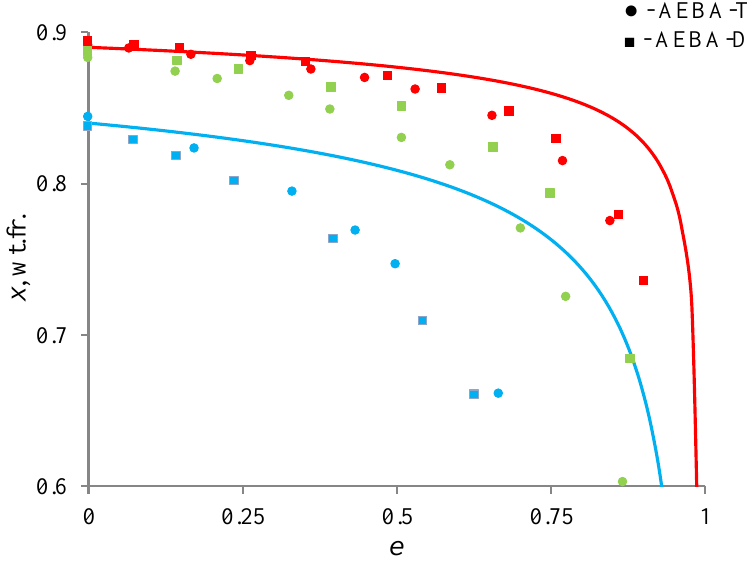
Figure 8. Change in the concentration of ethanol in a liquid mixture during open evaporation: red color is 0.1 wt.fr. of AEBA; green—0.2 wt.fr.; blue—0.6 wt.fr.